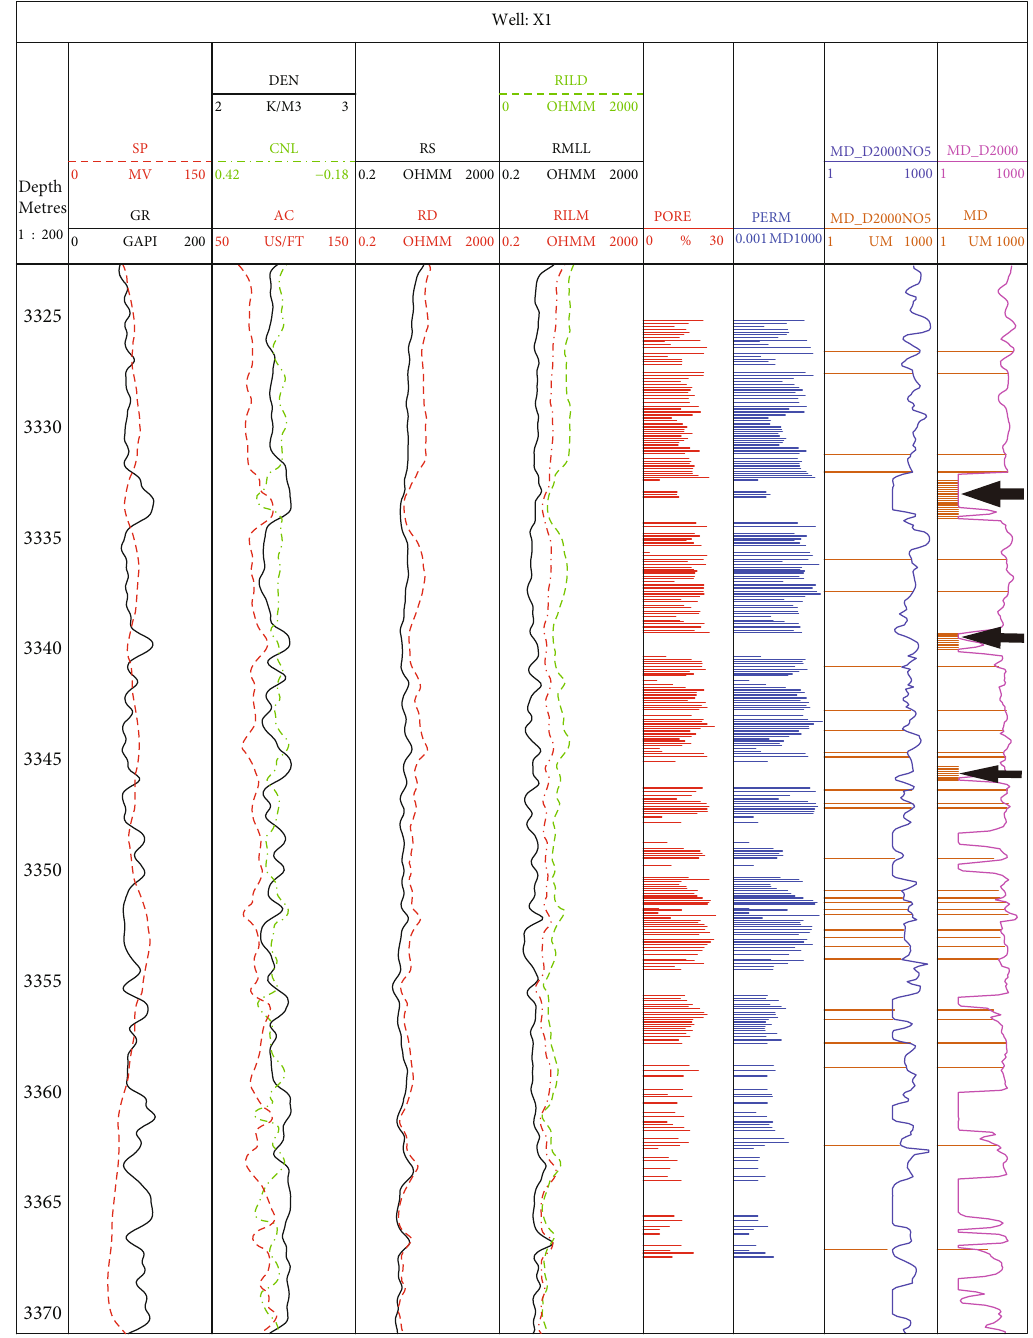
Figure 11: Comparison of the fi tting e ff ect before and after adding the geological constraints of the mudstone section in the S well